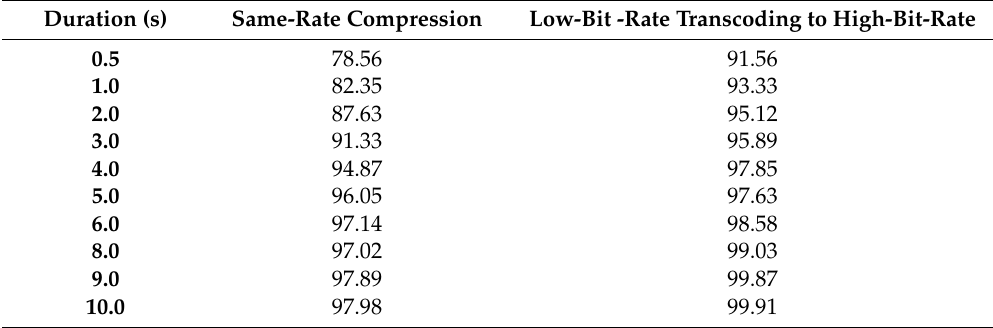
Table 9. AAC dual compression detection accuracy at different durations—FAAC (%).